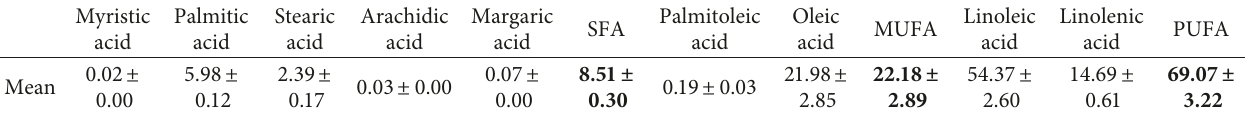
Table 4: Fatty acids analysis of kernel of Maras 18